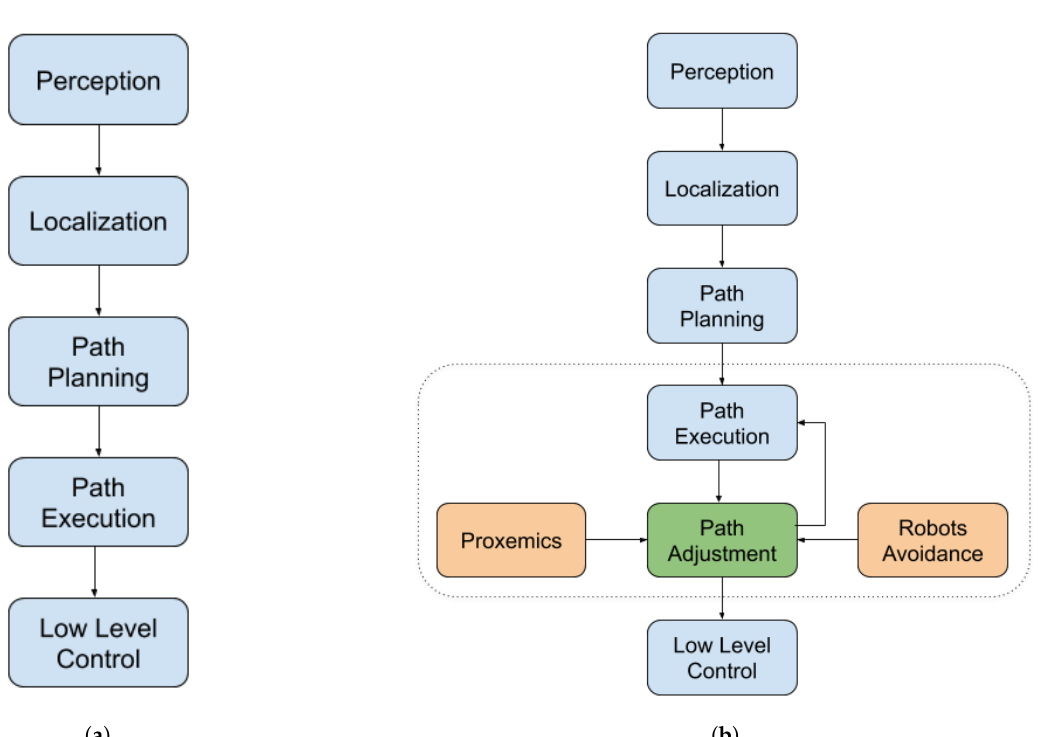
Figure 7. Navigation for autonomous robots comparison: ( a ) the traditional approach and ( b ) the proposed social naviga- tion